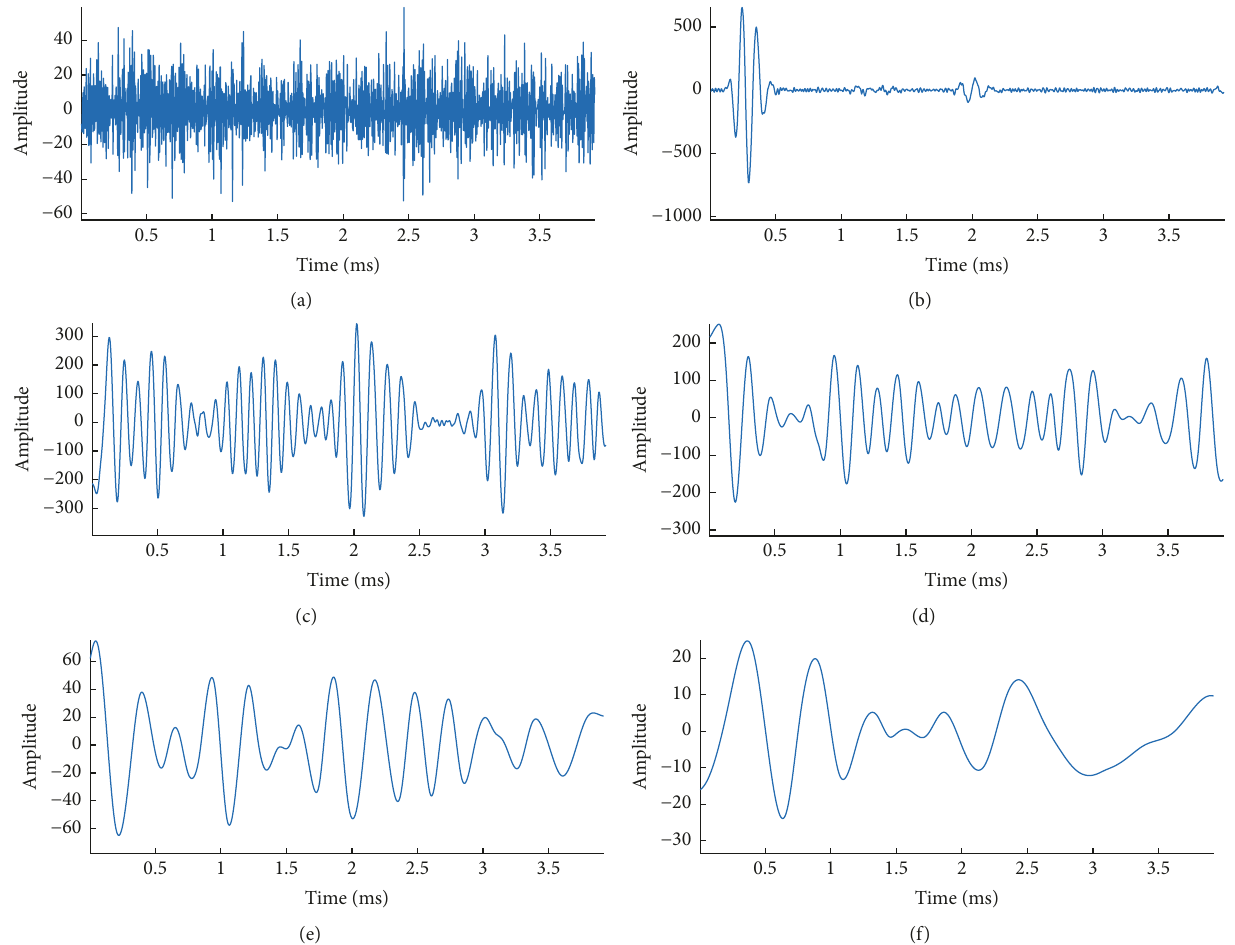
Figure 10: The IMF with the vibration signal after the decomposition with ICEEMD: (a) ∼ (f) show IMF1 ∼ 6 Signal decomposed with